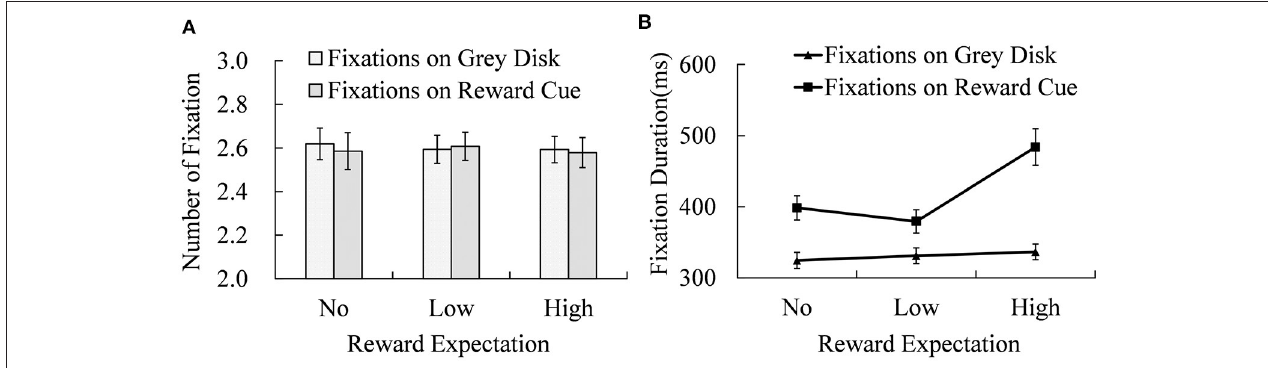
FIGURE 3 | The numbers of fixation (A) and mean fixation duration (B) on cue and non-cue under different reward expectation conditions. Error bars indicate the standard error of mean (SEM).